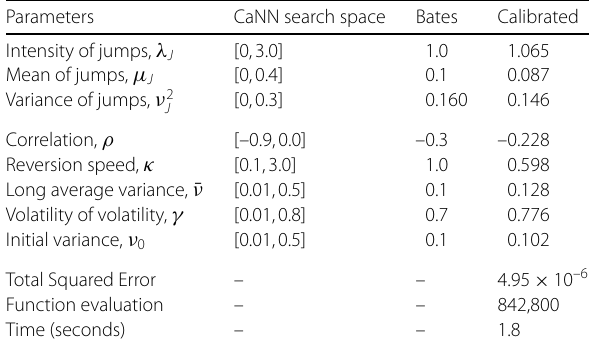
Figure 9 The solid lines represent the observed implied volatilities, with the dashed lines being the model calibrated ones. This plot shows the result with equal weights and ¯ λ = 1.0 × 10 –6 . The random seed is 2 during